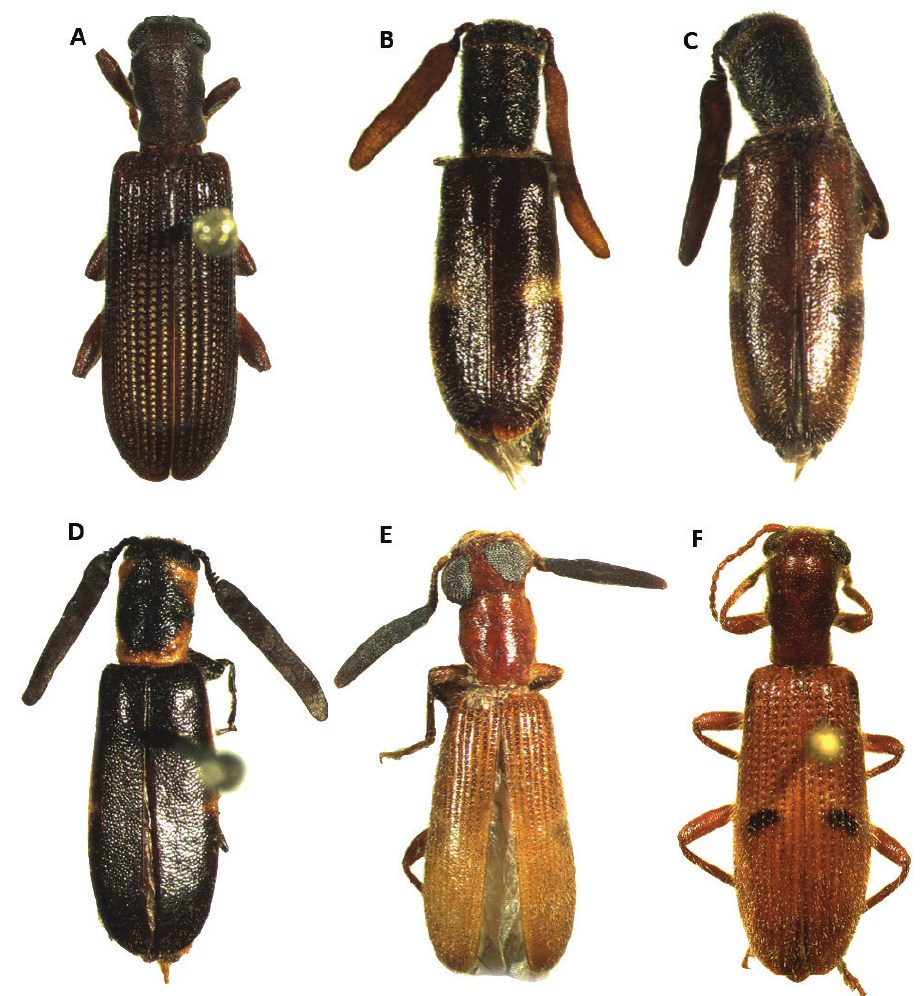
Figure 4. Habitus of: A Lecontella striatopunctata comb. n. B Monophylla californica C Monophylla pallipes D Monophylla terminata E Teloclerus compresicornis F Cymatodera bogcioides . striatopunctata has the posterior portion of the epipleural fold smooth, while L. brun- nea has the same portion of the epipleural fold moderately crenulate. Redescription. Male. Form: Small to large individuals, moderately robust. Color: Head, pronotum, thorax, scutellum, legs, antennae and elytra light testaceous to dark brown; mouthparts fuscous, last fourth of mandibles piceous to black; abdominal seg- ments testaceous to piceous; elytral disc devoid of any bands or fasciae (Fig. 4A). Head: Including eyes wider than pronotum; eyes large, taller than wide, bulging laterally, coarsely faceted, emarginate posteriorly; antennal notch located in front of emargination; frons bi-impressed; integument coarsely, conspicuously, shallowly